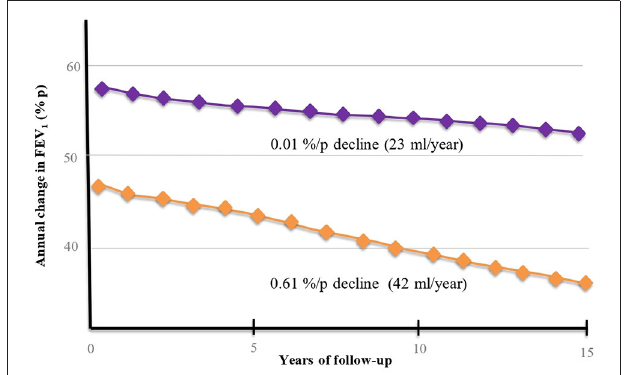
FIGURE 2 | FEV 1 decline over time in BE-COPD group ( ) and TE-COPD ( ) group. The Y axis shows annual change of FEV 1 as percent of predicted (%/p), whereas X axis shows FEV 1 decline through 15 years of follow up. In BE- COPD group the FEV 1 starts at higher values (%/p) than TE-COPD group. In order to compare the decline between groups we also show absolute values (ml/year). The annual decline in absolute values in TE-COPD group is two-fold faster than BE-COPD (42 vs. 23